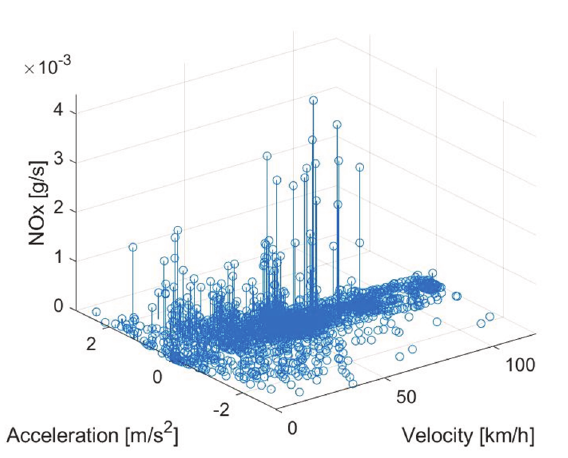
Fig, 15. Specific distance emission of CO 2 for selected parts of road tests